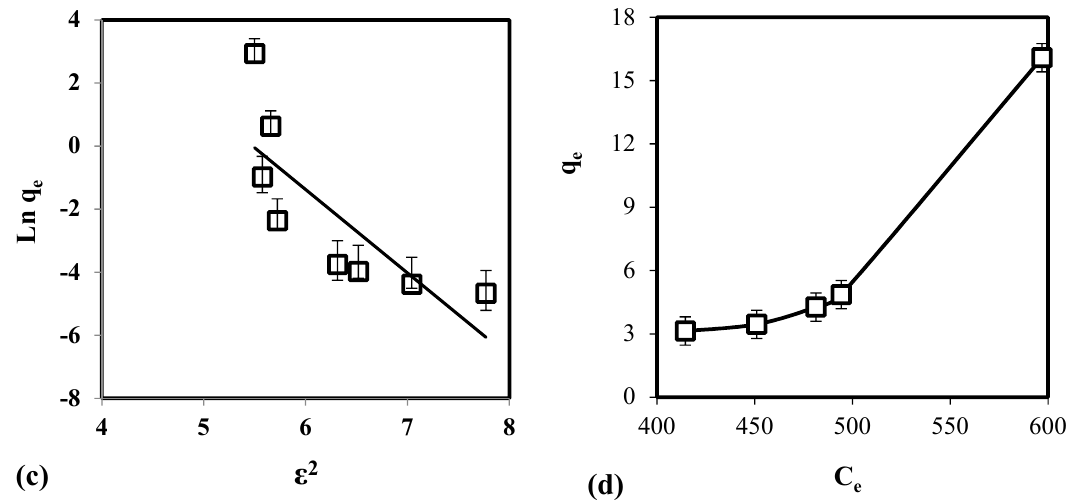
Figure 4. Equilibrium data fitted with ( a ) Freundlich, ( b ) Langmuir, ( c ) D-R, and ( d ) solvent-affinity isotherm for the adsorption of As(V) using CCB.